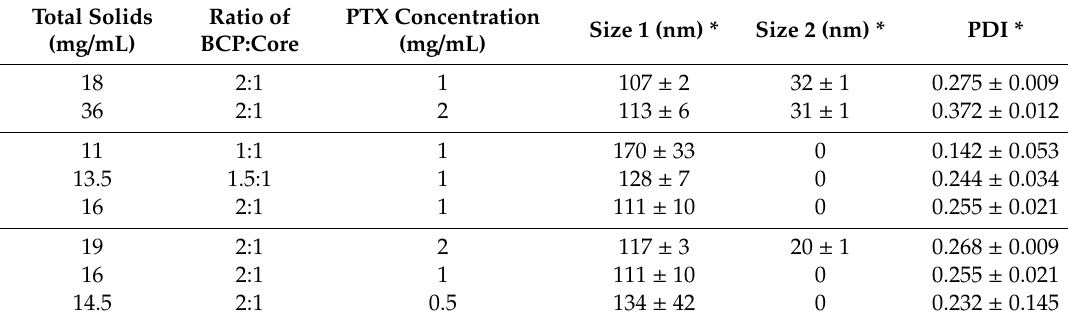
Table 1. Summary of paclitaxel nanoparticle